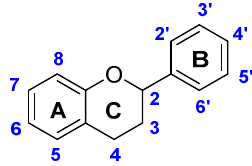
Figure 1. General chemical structure of flavonoids.